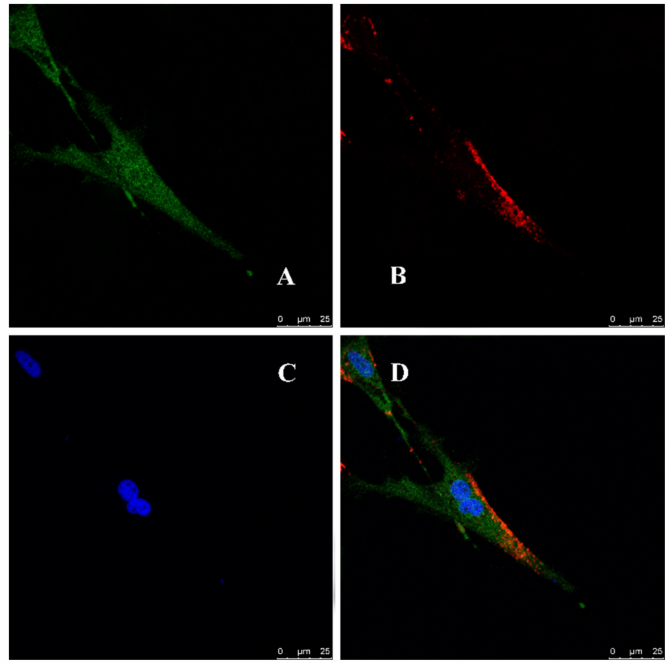
Figure 6. Co-localization of Lc UBE2G1 and ubiquitin in Larimichthys crocea head kidney cells detected by laser confocal microscopy. ( A ) Lc UBE2G1 displayed by Alexa Fluor 488-labeled secondary antibody (green); ( B ) Ubiquitin (Ub) displayed by Alexa Fluor 555-labeled secondary antibody (red); ( C ) Cell nuclei stained with DAPI (blue); ( D ) The combined graphs of ( A – C